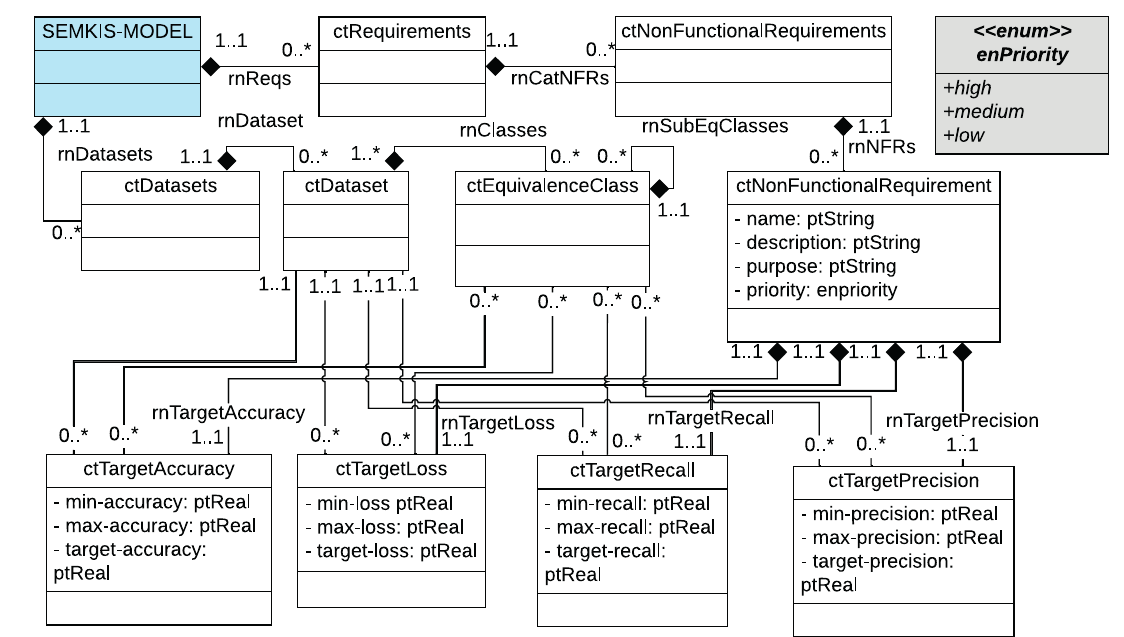
Figure 4. SEMKIS-DSL Metamodel: Nonfunctional requirements specification